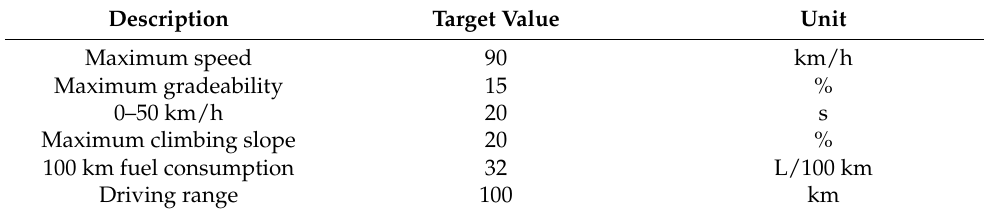
Table 2. Vehicle performance